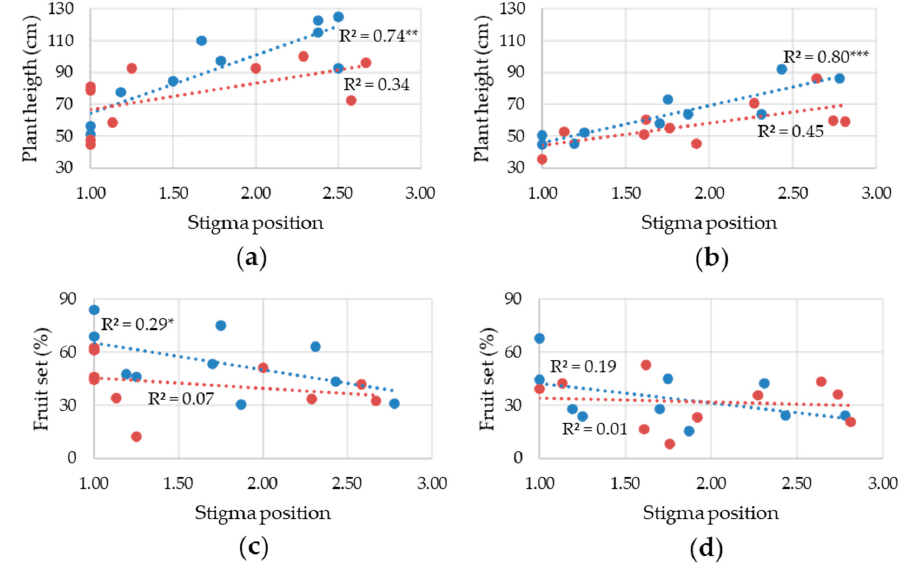
Figure 3. Linear regression between stigma position and plant height in ( a ) 2007 and ( b ) 2019 and between stigma position and fruit set in ( c ) 2007 and ( d ) 2019. In each graph, the regression in the control (blue dots and line) and in the heat (red dots and line) field is reported; for each regression, the determination coefficient (R 2 ) and the significance of the regression analysis of variance are reported. *, **, and *** indicate significant regressions for p ≤ 0.05, 0.01, and 0.001, respectively. Principal component analysis was separately carried out for the two years and the two fields. In 2007, the first two principal components (PCs) explained more than 78% and 70% of the total variance. In the control field, the first component was negatively loaded by PH and SP and positively by FSET; in the heat field, the loading factors were the same although with different signs (Table S3). PC2 was loaded by NF in the control and by PV under heat conditions. Genotype coordinates separated the varieties along the first axis, with cultivars showing the highest PC1 values under control conditions (Figure 4a). Among the studied landraces, those with the origin in the Latium and Umbria region, which can be considered autochthonous (SBol, Spa, TPer), still had positive PC1 values, corresponding to smaller plants, inserted stigma, and higher fertility, whereas the remain ‐ der were located on the negative part of the axis (Figure 4a). The heat conditions experi ‐ enced in this year did not change the variety distribution, which was specular but parallel to that detected in the control field (Figure 4b). Multivariate analysis on 2019 data explained 76% and 63% of the variability with the first two PCs under control and heat conditions, respectively. In this case, PC1 was posi ‐ tively loaded by PH and SP under both conditions (Table S3). In the control field, FSET also had an important negative loading on PC1. Main loadings for PC2 were PV (positive) in the control and FSET (negative) in the heat field. PC1 loadings made the topography of accessions under control conditions mirror the one observed in 2007; the general distribu ‐ tion of genotypes was similar except for SBol that showed PC1 values comparable to the cultivars (Figure 4c). Under heat conditions, the topography was changed, with the culti ‐ var MON located between landraces and the non ‐ autochthonous landrace Can positioned among the cultivars CHI and SAL, but with a different PC2 score due to a lower FSET (Figure 4d). Notably, autochthonous landraces also maintained an intermediate position under these harshest tested conditions (Figure 4d).